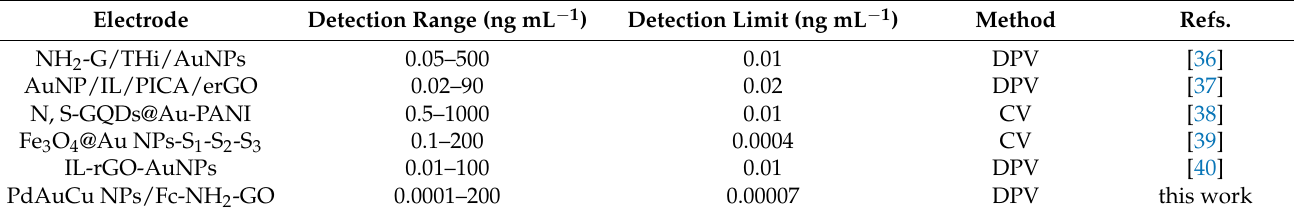
Figure 6. ( A ) DPV responses of the proposed immunosensor after incubation with various concentrations of CEA in 0.01 M PBS (pH 7.4) (a–j: 0, 0.1, 1, 10, 100, 1000, 10,000, 50,000, 100,000, 200,000 pg · mL − 1 ). ( B ) Linear relationship between the ∆ I of the immunosensor and logarithm of CEA concentration. Error bars represent the standard deviation, n = 5. Table 1. Comparison of the characteristics of various modified electrodes.